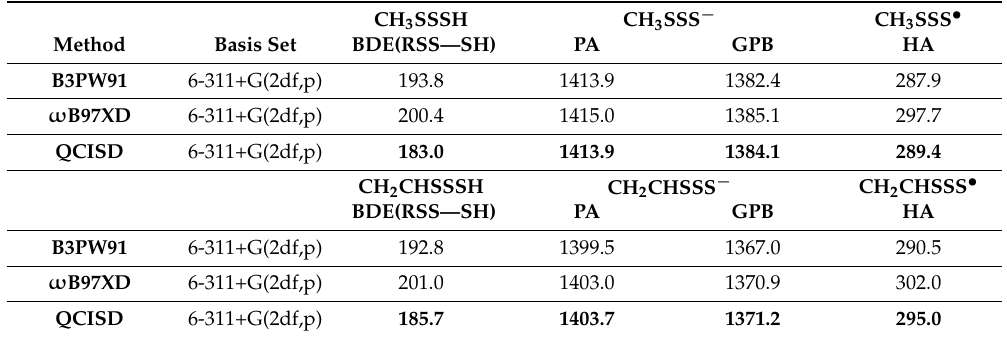
Table 7. Homolytic RS − SH bond dissociation enthalpy (BDE) of RSSSH, proton affinity (PA) and gas-phase basicity (GPB) of RSSS − , and hydrogen affinity (HA) of RSSS • (R = CH 3 , CH 2 CH). All energies calculated at 298.15K and in kJ mol − 1 (see Section 3). CH 3 SSSH CH 3 SSS